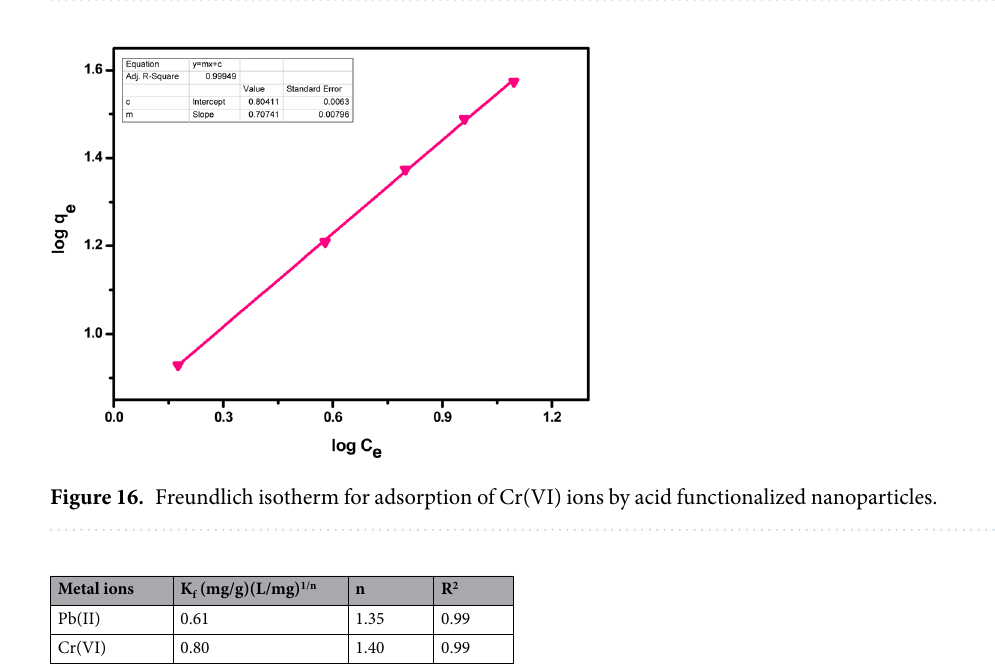
Figure 15. Freundlich isotherm for adsorption of Pb(II) ions by acid functionalized nanoparticles.